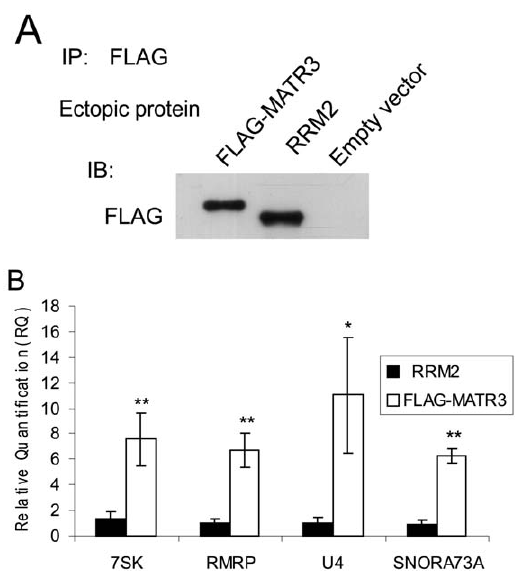
Figure 3. Validation of RIP-seq results. ( A ) HEK293T cells were transfected with the indicated MATR3 constructs and the ectopic MATR3 proteins were immunoprecipitated using FLAG-conjugated beads and blotted with the indicated antibodies. ( B ) RNA was extracted from the immune complexes, yeast Phe-tRNA was added, qPCR was carried out on reverse transcription products and the Relative Quantification (RQ) is shown as fold-change of signal compared to D RRM2 minus the background of the empty vector. The plot represents the mean of three independent experiments and error bars represent SD (*P # 0.05, **P # 0.01, t test).